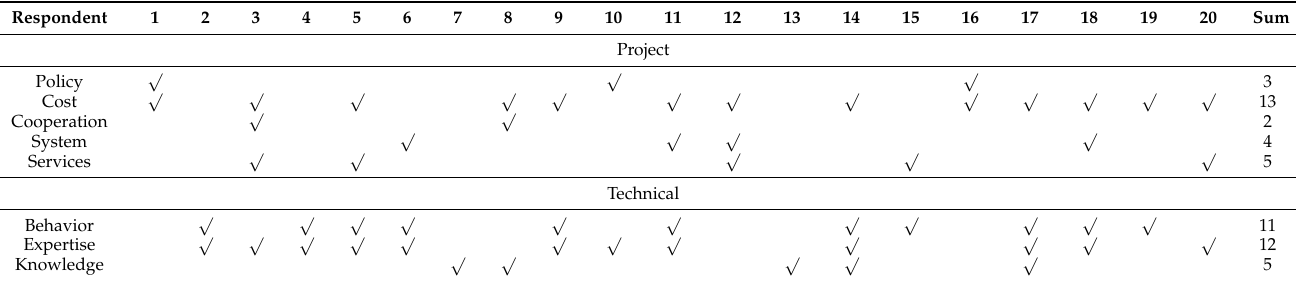
Figure 4. Summary of challenges to creating trust in BIM-based construction projects. Table 4. Challenges to creating trust in BIM-based construction projects.